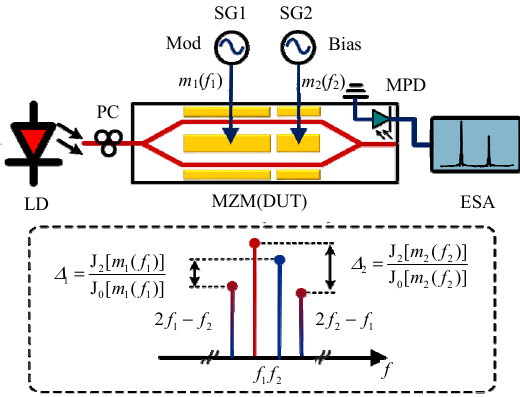
Fig. 1 Schematic diagram of the proposed method. LD: laser diode; PC: polarization controller; MPD: monitor photodetector; Mod: modulation; SG: sinusoidal-function generator; ESA: electrical spectrum